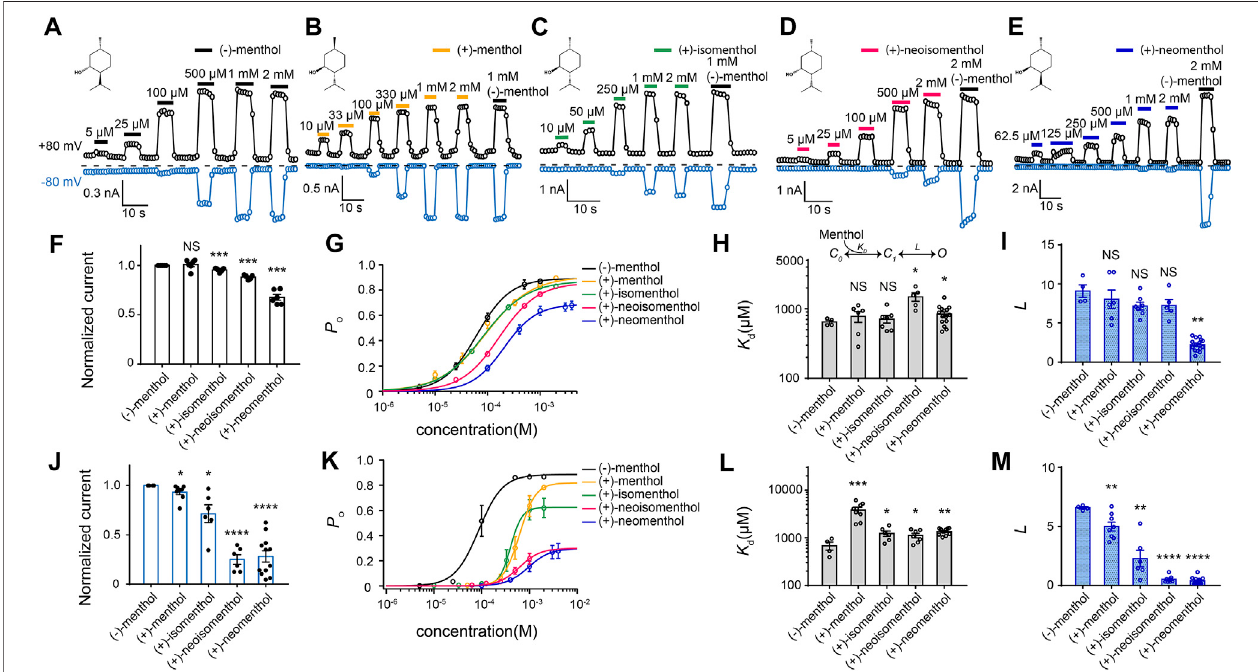
FIGURE1| DifferentialactivationofmouseTRPM8 bymentholstereoisomers. (A – E) Representativewhole-cell recordingsofmouse TRPM8activated bydifferent menthol stereoisomers in a concentration-dependent manner. The chemical structures of menthol stereoisomers are shown on upper left. (F) Bar graph of normalized currents induced by menthol stereoisomers at +80 mV from HEK293T cells transfected with mouse TRPM8 recorded in whole-cell con fi guration ( n = 4 – 7 for each isomer, two-sided t -test, * p < 0.05; ** p < 0.01; *** p < 0.001; **** p < 0.0001; NS, not statistically signi fi cant). Stereoisomers invoked max current amplitudes that were normalized to the response to 2 mM ( − )-menthol. (G) Concentration – response curve of menthol stereoisomers activation measured from whole-cell patch-clamp recordings at +80 mV ( n = 4 – 7). (H,I) General gating scheme where the ligand binding is represented by K d , and the equilibrium constant between the closed and open states upon ligand binding is represented by L . For different stereoisomers, K d and L values were calculated from concentration – response curves in (G) ( n = 4 – 7, two- sided t -test, * p < 0.05; ** p < 0.01; *** p < 0.001; **** p < 0.0001; NS, not statistically signi fi cant). All statistical data are given as mean ± s.e.m. (J) Bar graph ofnormalized currents induced by menthol stereoisomers from HEK293T cells transfected with mouse TRPM8 recorded in whole-cell con fi guration ( n = 4 – 7 for each isomer, two- sided t -test, * p < 0.05; ** p < 0.01; *** p < 0.001; **** p < 0.0001; NS, not statistically signi fi cant). Stereoisomers invoked max current amplitudes that were normalized to the response to 2 mM ( − )-menthol. (K) Concentration – response curve of menthol stereoisomers activation measured from whole-cell patch-clamp recordings at − 80 mV ( n = 4 – 7, two-sided t -test, * p < 0.05; ** p < 0.01; *** p < 0.001; **** p < 0.0001; NS, not statistically signi fi cant). (L,M) At − 80 mV, K d and L values of different stereoisomers were calculated from concentration – response curves in (K) . All statistical data are given as mean ±